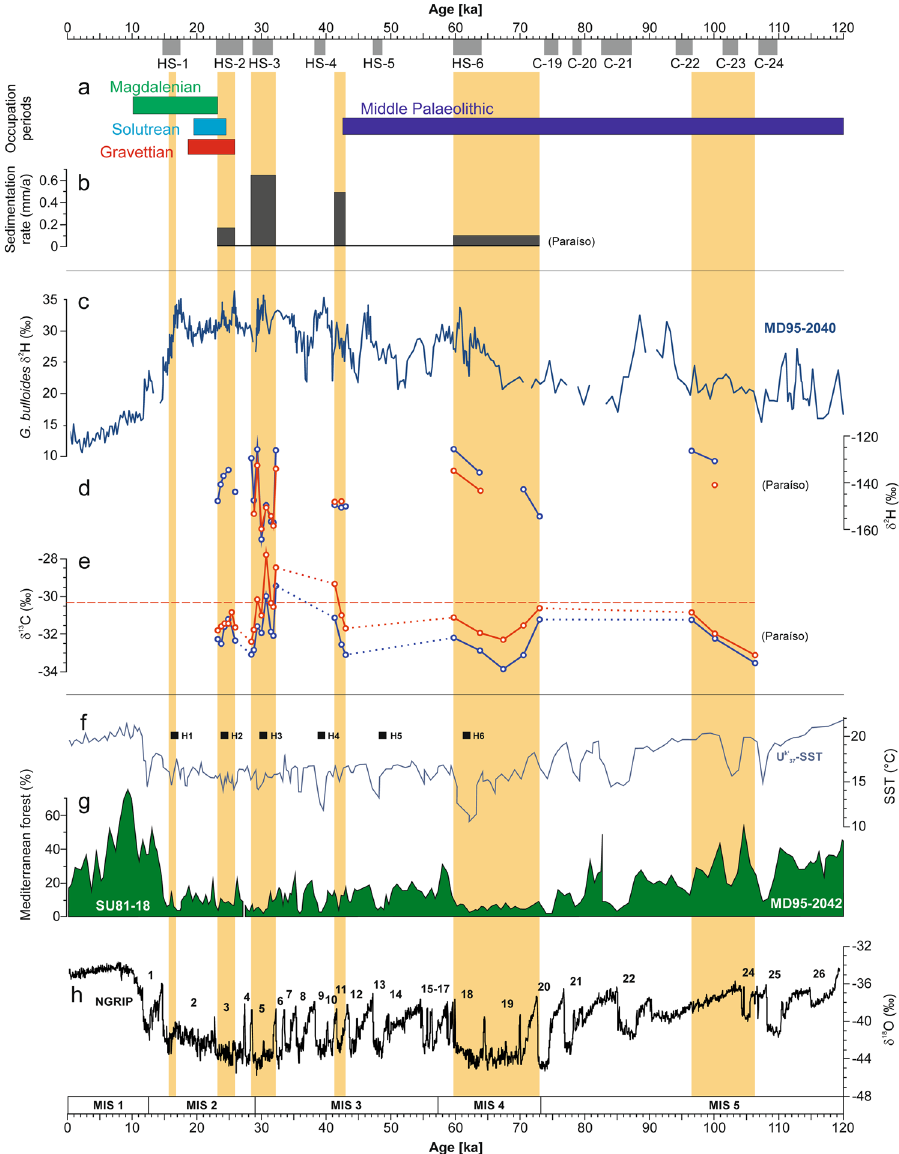
Figure 3. Main loess deposition periods (indicated by vertical ochre bars) in the upper Tagus Basin from the past 120 kyrs compared with human occupation patterns of interior Iberia and other palaeo-climate indicators from marine and ice-core records. ( a ) Temporal placement of Upper Palaeolithic and Middle Palaeolithic occupations of interior Iberia are based on the results presented in SI Text 9. ( b ) Loess deposition rates were estimated based on the thickness of loess units and the mean of obtained OSL ages. ( c ) δ 2 H record on G. bulloides of core MD95-2040 36 ; δ 2 H values were calculated based on δ 18 O values using the global meteoric water line. ( d ) δ 2 H values of the n -alkane compounds n-C 29 (red) and n-C 31 (blue) from the loess section Paraíso 35 . ( e ) δ 13 C values of the n -alkane compounds n-C 29 (red) and n-C 31 (blue) from the loess section Paraíso 35 ; the red dotted line marks the estimated limit for habitability of the interior of Iberia. ( f ) SST of marine drilling core MD95-2042 and SU81-18 33 , and Heinrich Events detected in the same core. ( g ) Pollen percentage of Mediterranean forest from core MD95-2042 and SU81-18 33 . ( h ) δ 18 O record of the NGRIP ice core with numbers referring to stadials 46 . Timing of HS-1 to HS-6 (Heinrich stadials) is based on ref. 46 , and C-19 to C-24 (North Atlantic ice rafting events) on ref. 75